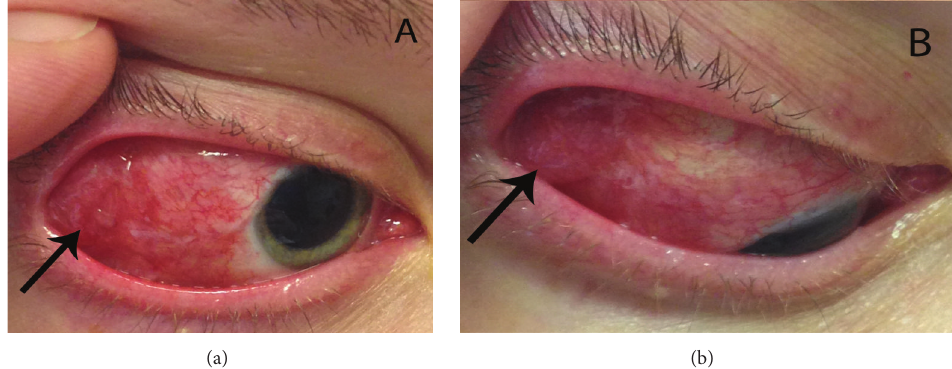
Figure 1: (a) Clinical photograph of the patient’s right eye. Note the red, elevated mass temporally underneath a closed and scarred conjunctiva. Pupil is pharmacologically dilated. (b) Right eye in downgaze and adduction.